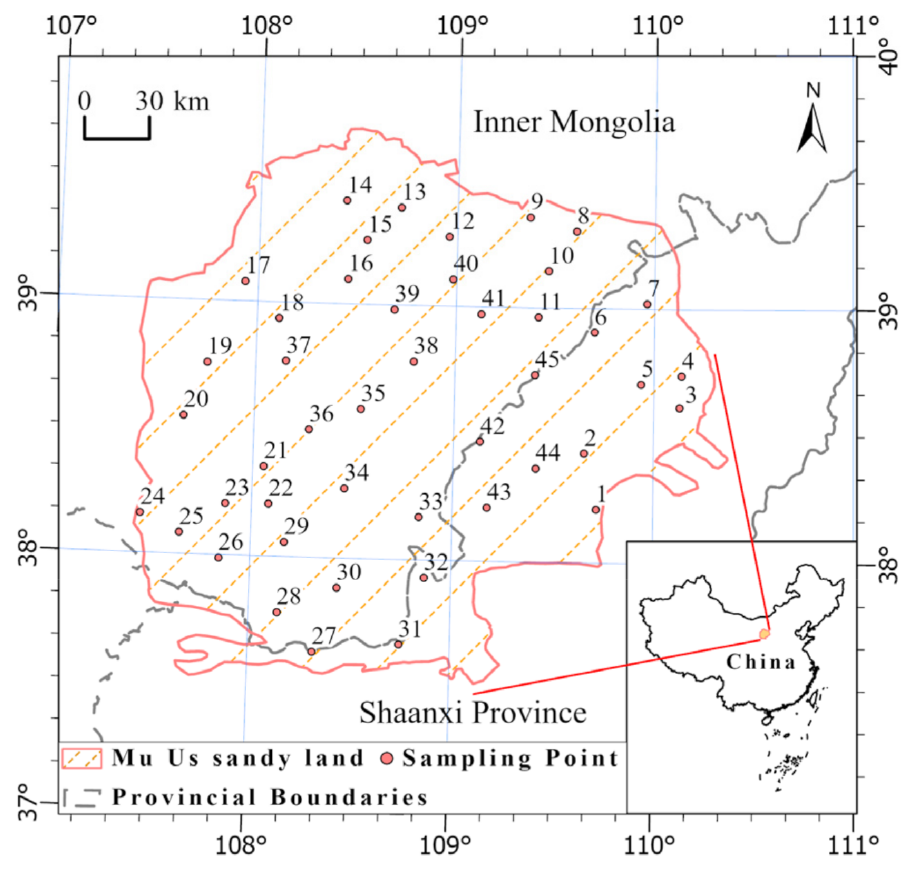
Figure 1. Overview of the study